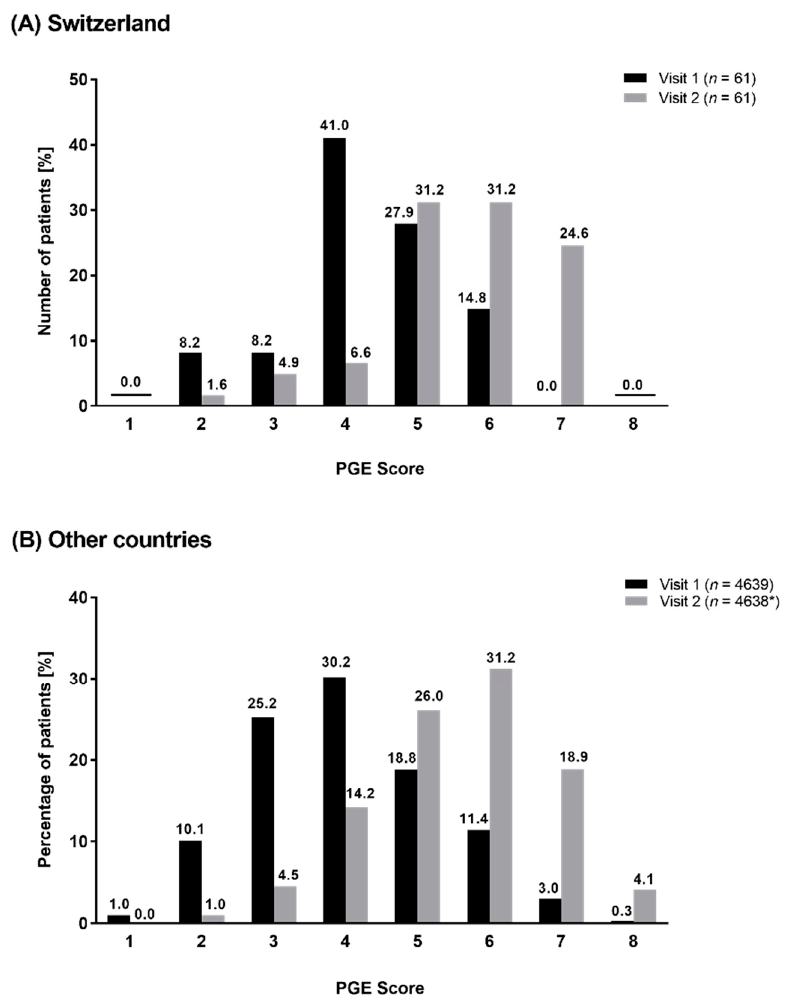
Figure 4. Distribution of PGE Score at visit 1 and at visit 2 in Switzerland ( A ) and in other countries ( B ). * one patient was ( B ). * one patient was excluded.